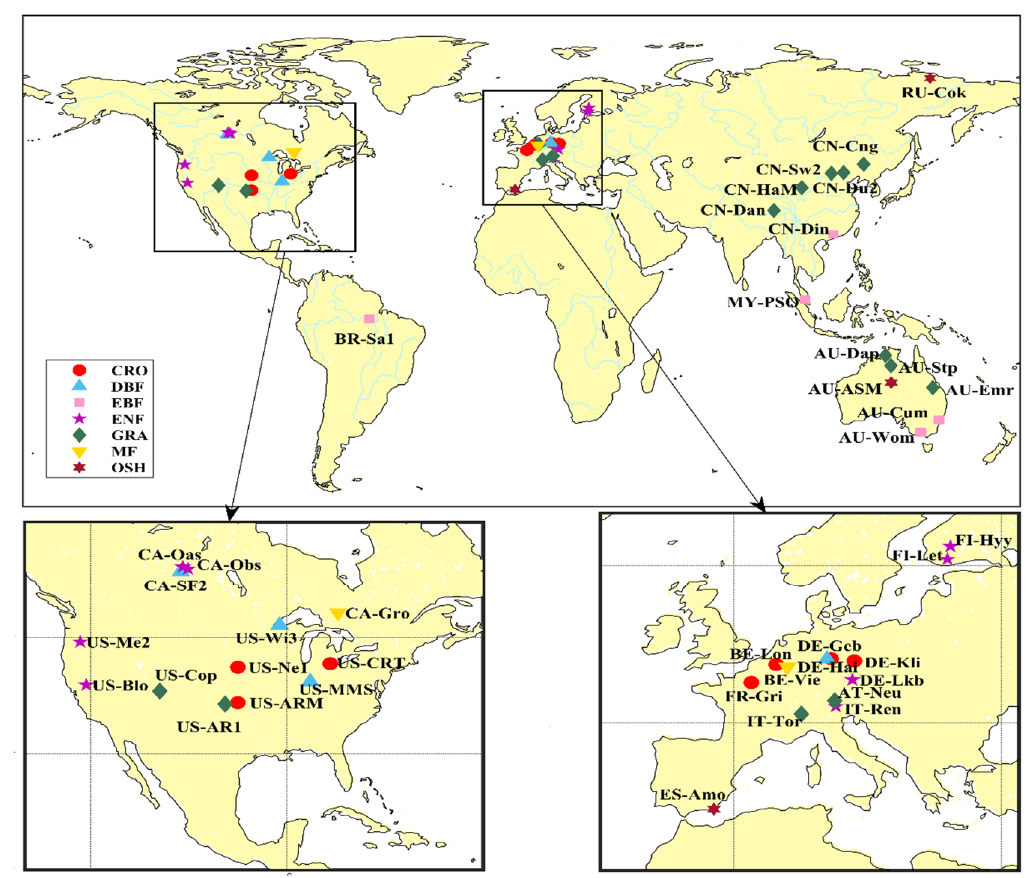
Figure 1. Location of the 43 FLUXNET sites. The biomes types are identified based on the International Geosphere-Biosphere Programme (IGBP) biome classification.